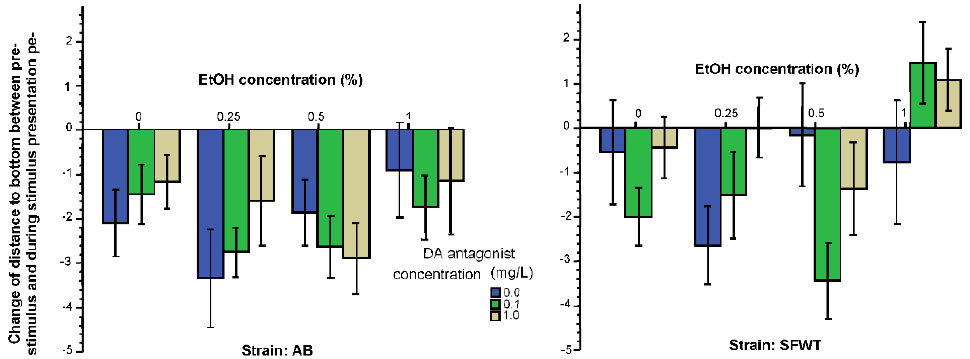
Figure 4. Change of distance to bottom elicited by the presentation of animated conspecific images is influenced by the concentration of acute alcohol (X-axis) and by the strain origin of the fish, but not by the concentration of acute D1-R antagonist (legend). Mean ± S.E.M. are shown. Intra-individual temporal variance of distance to bottom reflects how much the fish